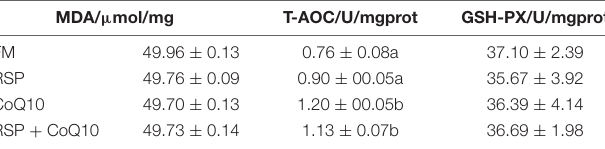
TABLE 5 | Immune parameters of L. vannamei challenged the acute salinity change